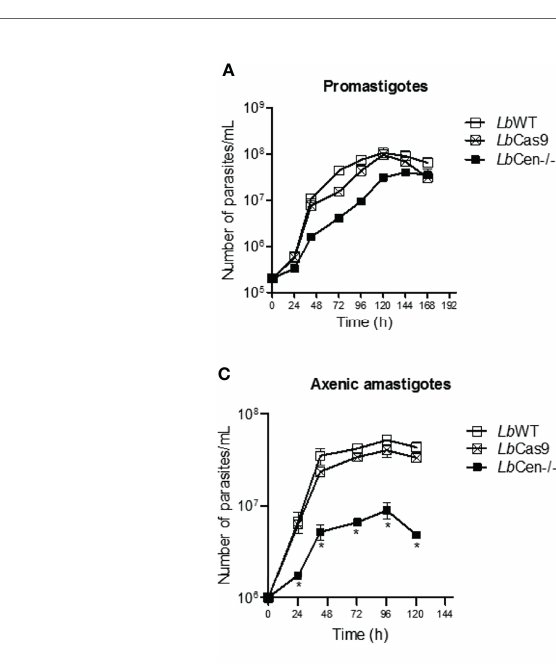
( Figure 5D ). CRISPR-mediated deletion of centrin in L. braziliensis yielded a cell line that displayed slower growth at the amastigote stage, with similar morphological changes as those described in L. donovani centrin − / − mutants (Selvapandiyan et al., 2004).